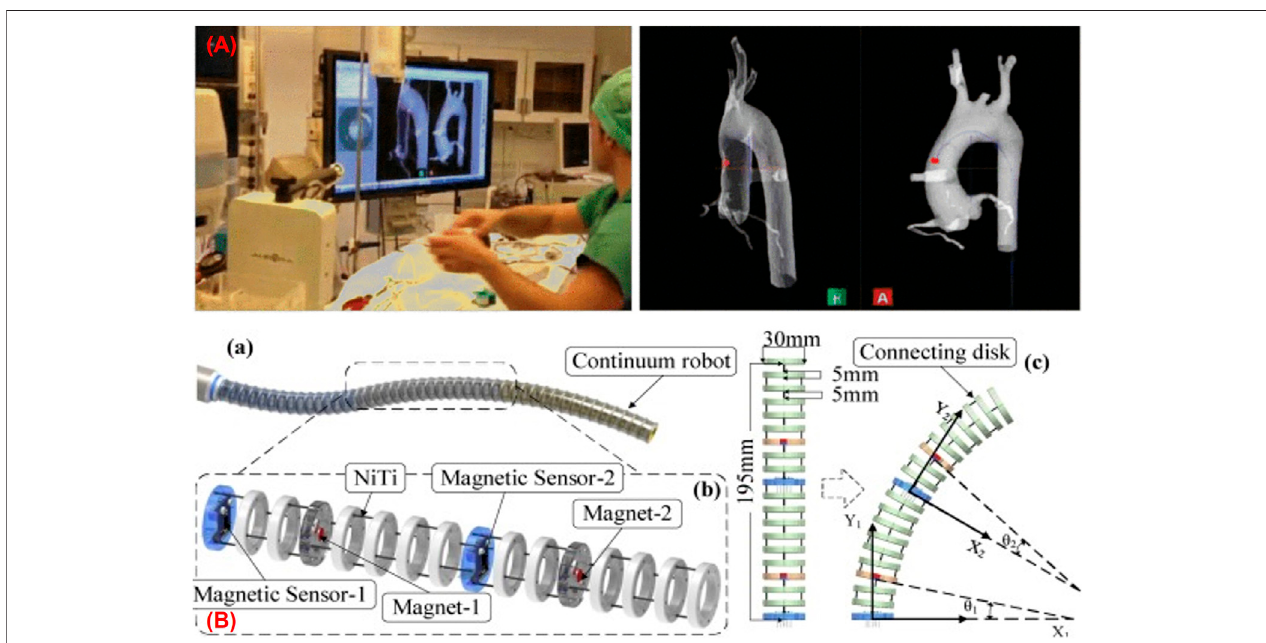
FIGURE 4 | (A) Catheter navigation using EM sensor (Dore et al., 2012) (B) continuum robot shape estimation using permanent magnets (Guo et al., 2019).